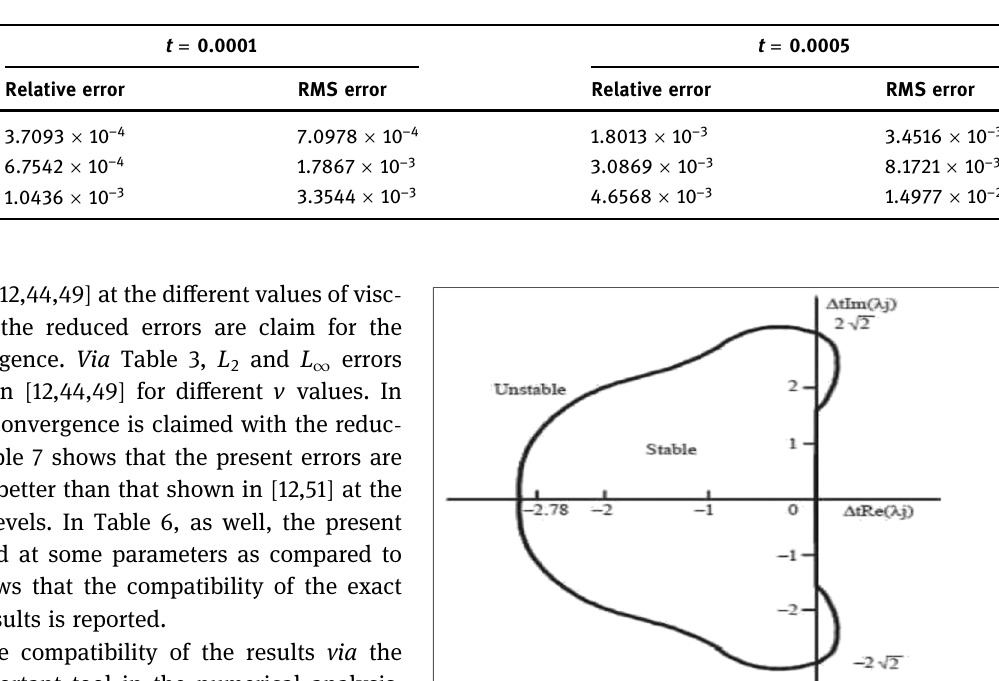
Table 14: Relative and RMS errors at = t 0.0001 and = t 0.0005 , respectively, with